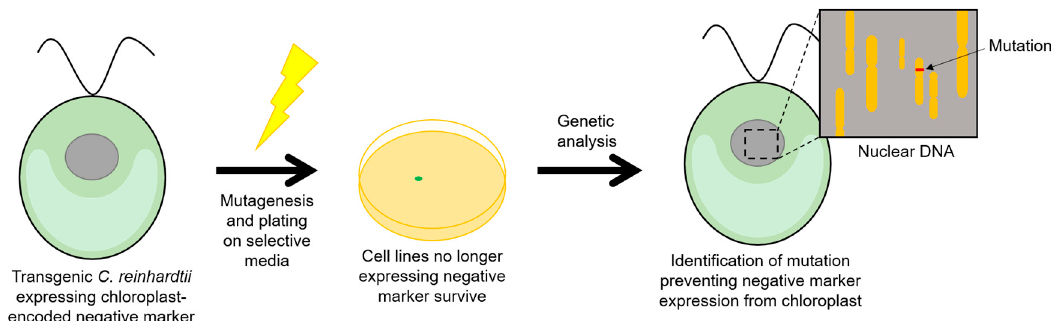
Figure 5. Use of negative selectable markers to identify nuclear-encoded factors required for chloroplast gene expression. A transgenic line is established expressing the negative marker (e.g., crCD [66]) in the chloroplast under the control of an endogenous promoter/5 ′ UTR element. Subsequently, a forward-genetic screen is performed by random mutagenesis to recover colonies able to survive on the selective media, including those mutants no longer expressing both the negative marker and the endogenous gene because of the loss of a nuclear-encoded factor. Phenotypic and western analysis is used to confirm such mutants, and genetic analysis identifies the nuclear gene encoding the factor [66].